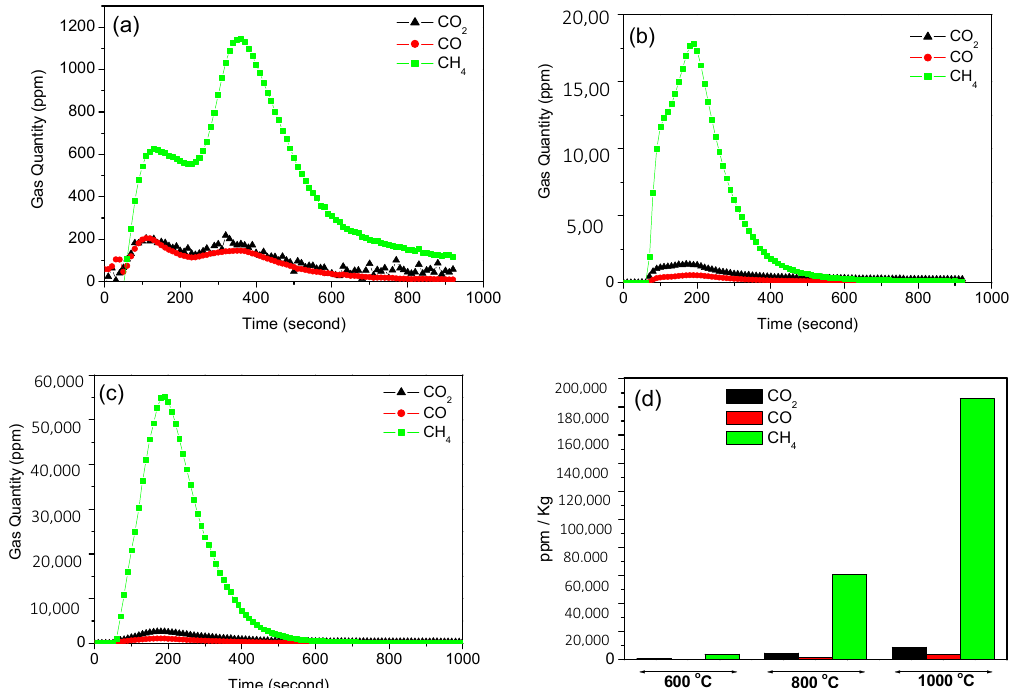
Figure 5. Quantitative gas released during heat treatment at preheated horizontal furnace: ( a ) 600 °C, ( b ) 800 °C, and ( c ) 1000 °C; ( d ) Comparison of gas released (CO, CO 2 and CH 4 ) at different temperatures.